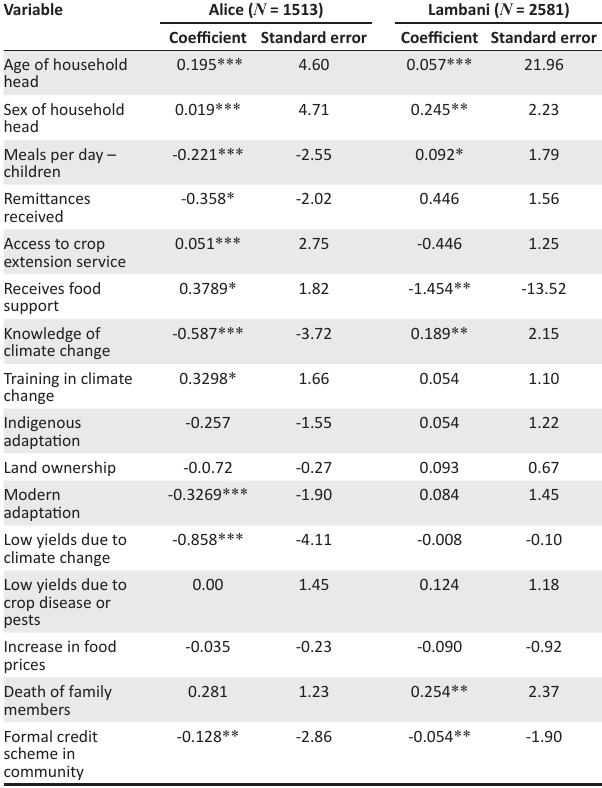
TABLE 4: The factors influencing the vulnerability category of households in Alice and